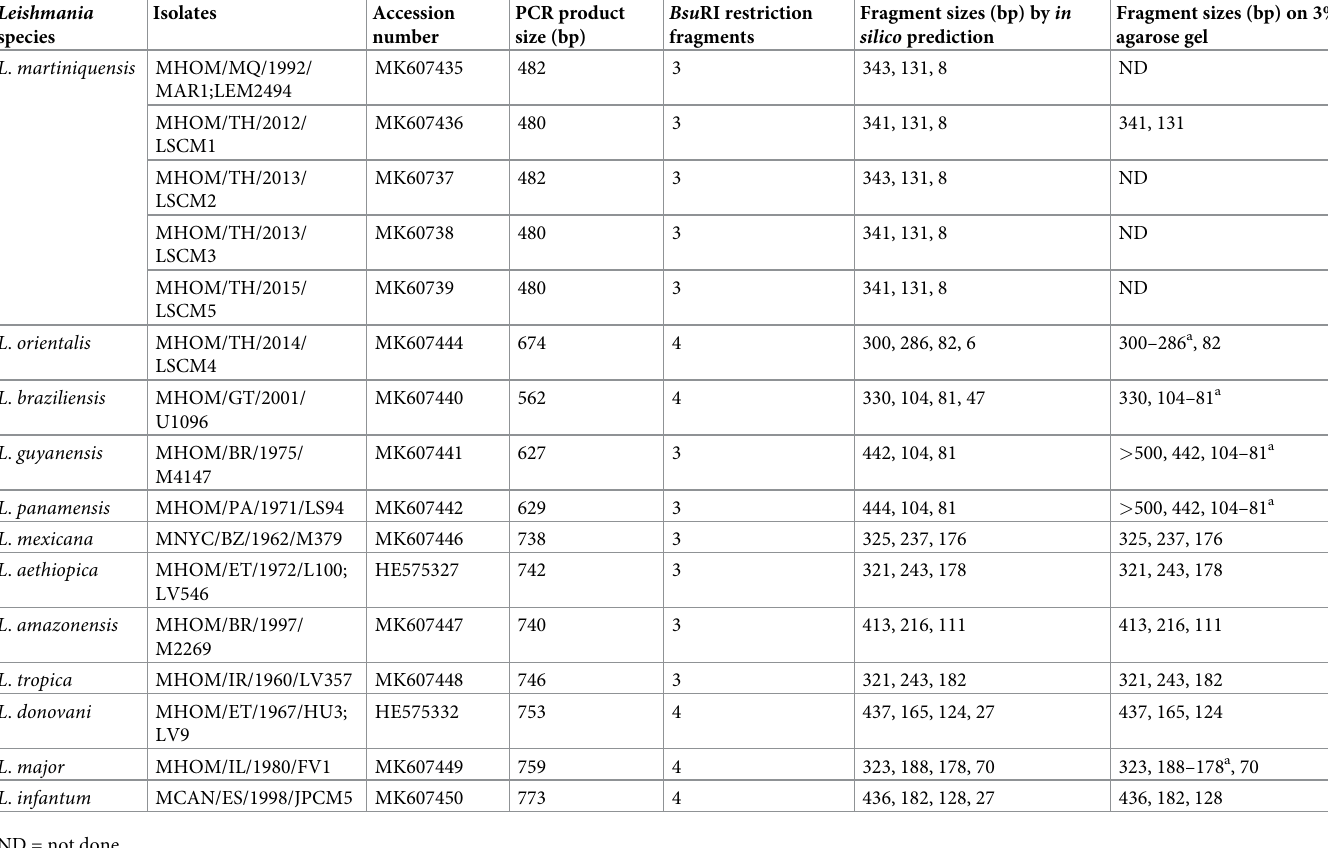
Merged band from 2 DNA fragments that were different in size approximately 20 bp or